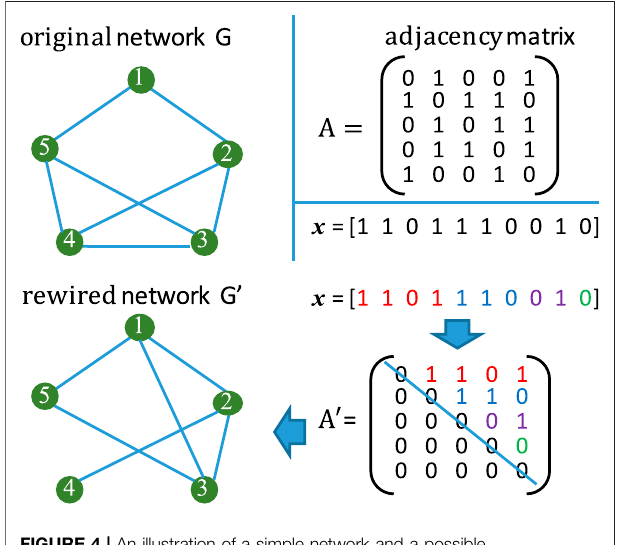
FIGURE 4 | An illustration of a simple network and a possible representation of a particle